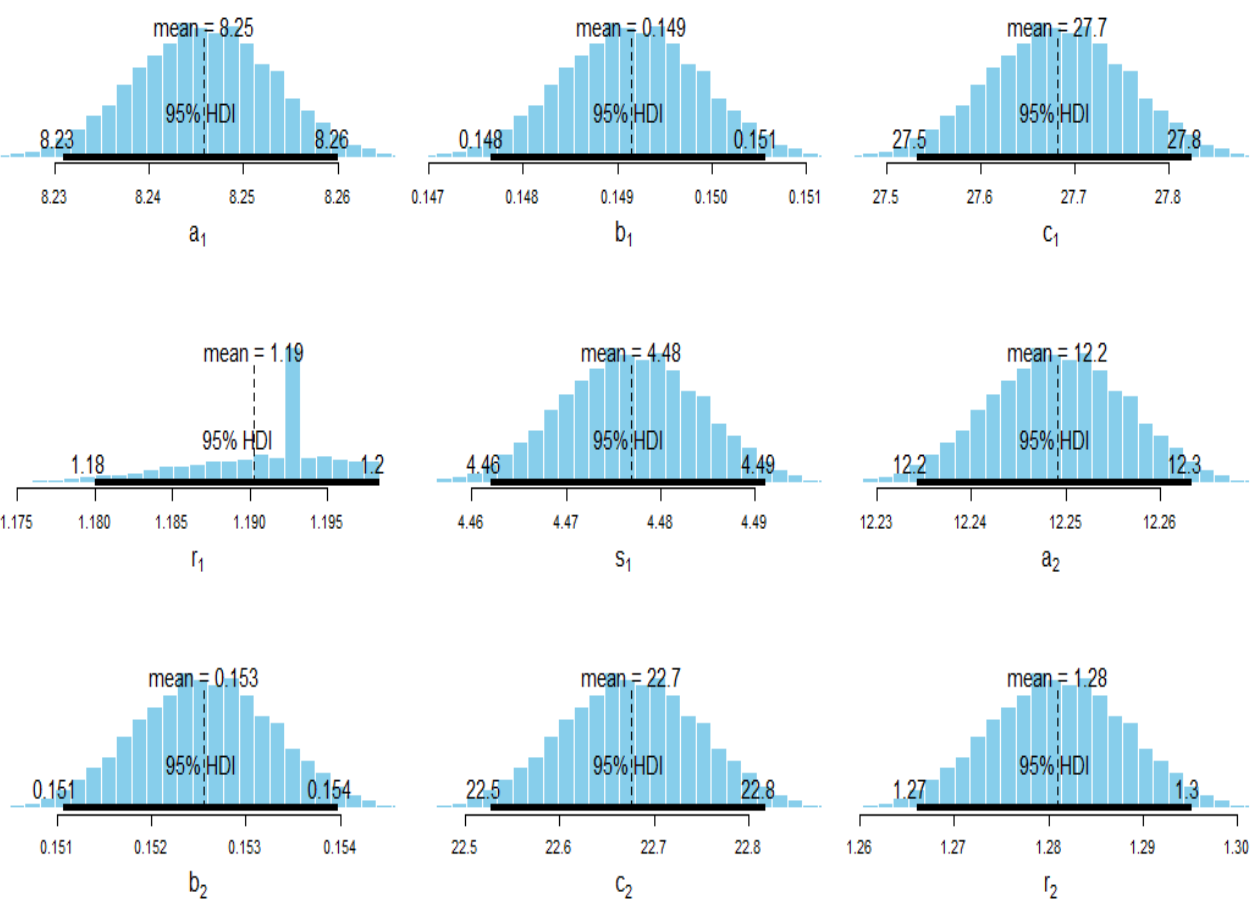
Figure 6. MCMC density and HDI intervals for results of Bayesian estimation of model for complete Bladder data for 9 parameters.